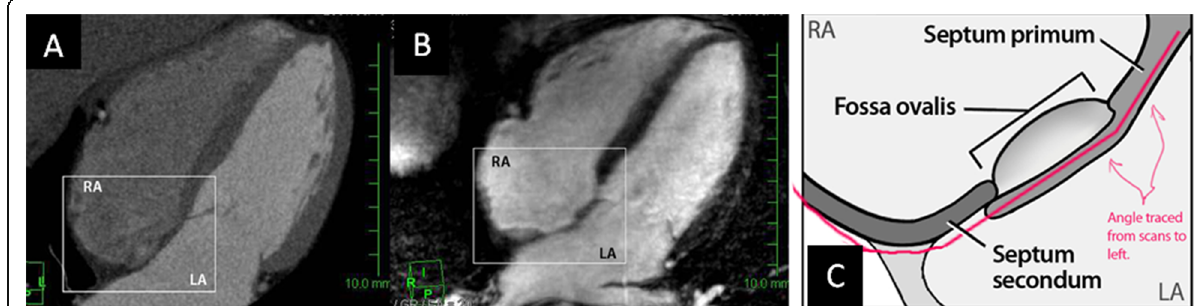
Fig. 1 Interatrial septum, as shown by a MSCT, b MRI, and c illustrated sketch diagram. The latter shows detailed anatomical and morphological features of the IAS. LA, left atrium; RA, right atrium